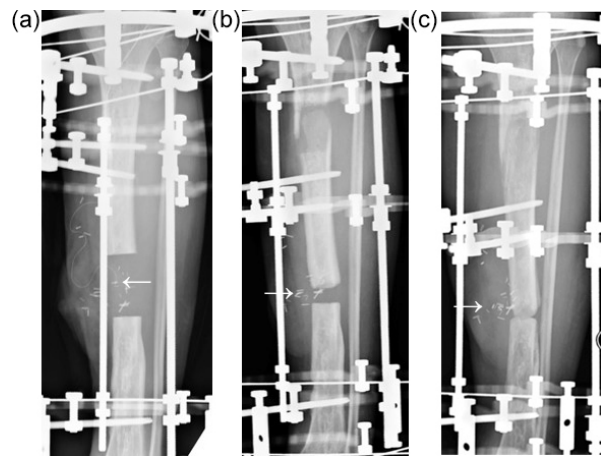
Figure 4. This open tibial fracture was initially treated with an in- tramedullary nail but developed a large segment of infected dead bone. He had a segmental excision (6cm) with a free gracilis muscle flap (a) . The white arrow indicates the position of the vascular anas- tomosis on the underside of the flap (identified by the metallic flow coupler). During bone transport, the muscle flap is gradually pushed out of the bone defect by the advancing transport segment and the vascular pedicle is displaced distally and medially (b) . At docking, the anastomosis has moved medially (c) . The vascular pedicle has lengthened by about 5cm during transport. The flap remained well perfused and